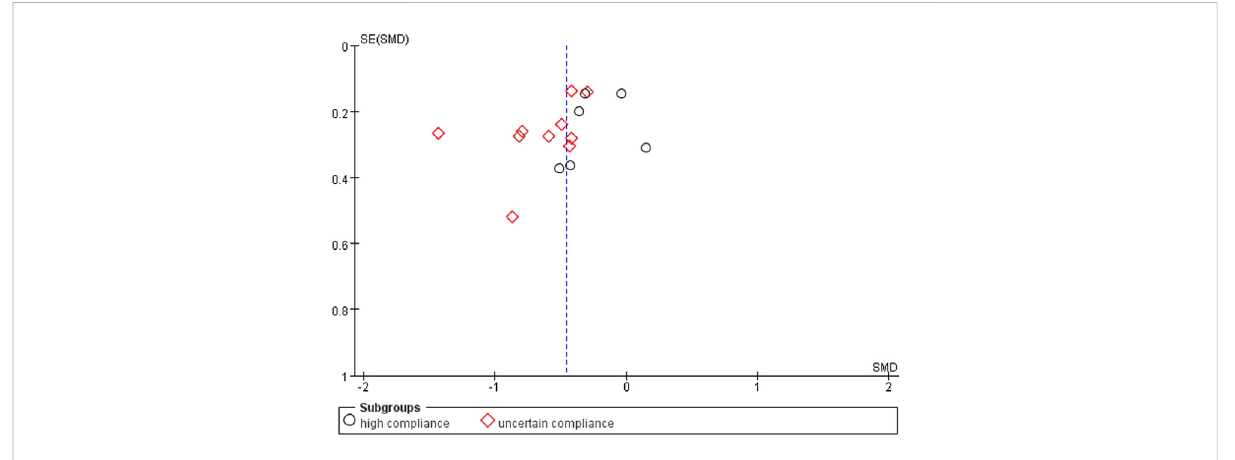
FIGURE 8 Funnel plots for physical function: Symmetric funnel plots showed no publication bias. SE, standard error; SMD, standardized mean difference.